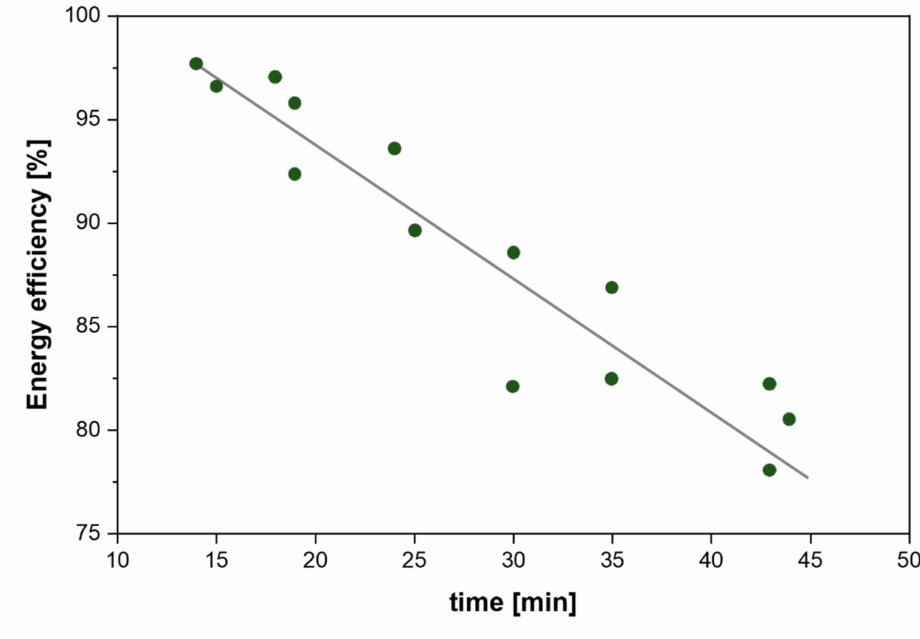
Figure 2. MAHD energy efficiency (%) at different extraction times. Adapted with permission from Bustamente et al. [48]. Copyright (2016) Elsevier